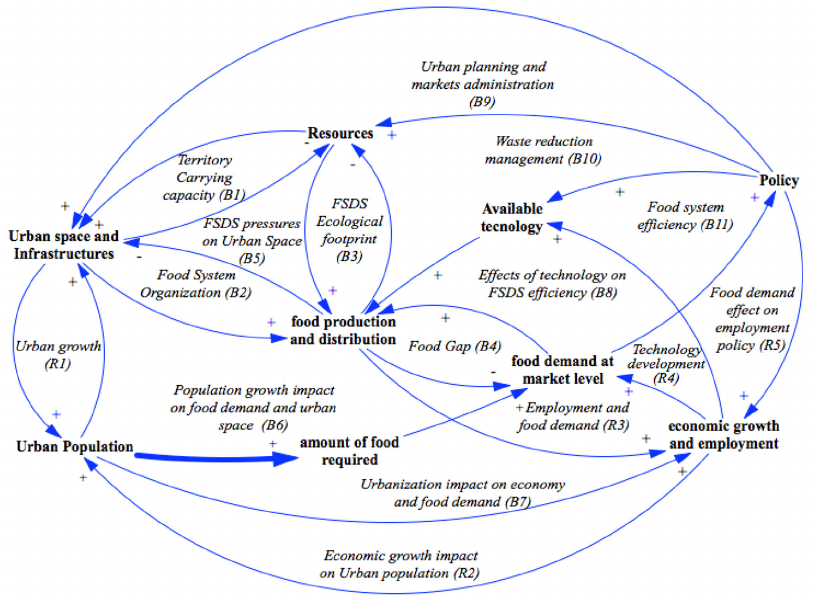
Figure 3. FSDS framework model adapted from Armendariz et al. [29 ].